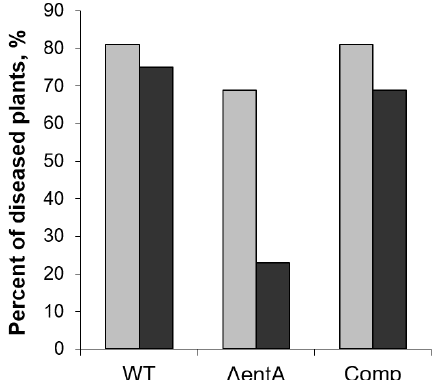
Figure 6. The percent of non-primed (light grey) and salicylic acid-primed (dark grey) tobacco plants showing disease symptoms after infection with the wild type (WT), or ∆ entA mutant ( ∆ entA ), or ∆ entA complementation mutant (Comp) of Pectobacterium atrosepticum SCRI1043. The priming was performed one day before the inoculation. The symptoms were analyzed three days post infection.